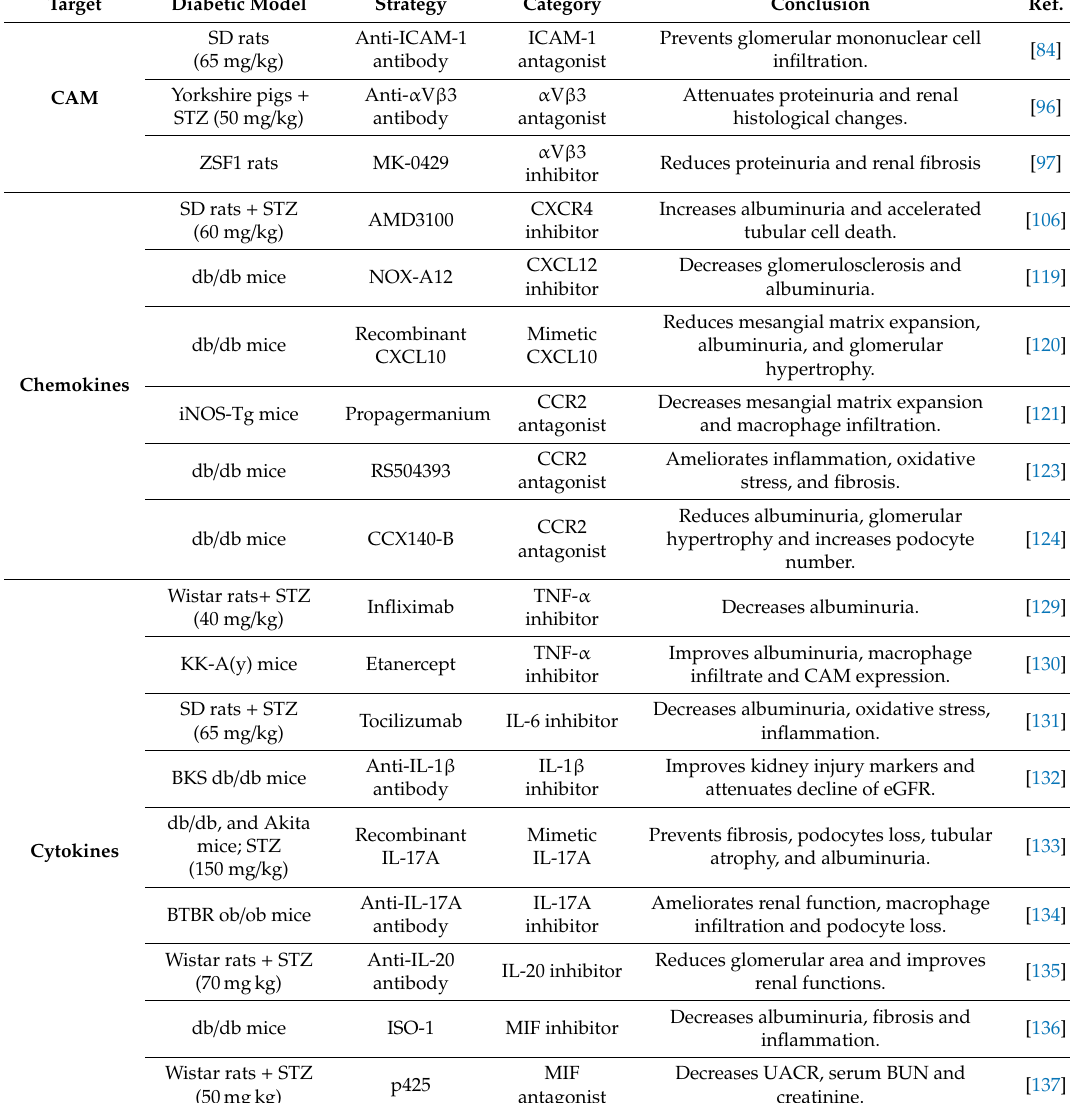
Table 1. Selected preclinical studies targeting inflammatory mediators in